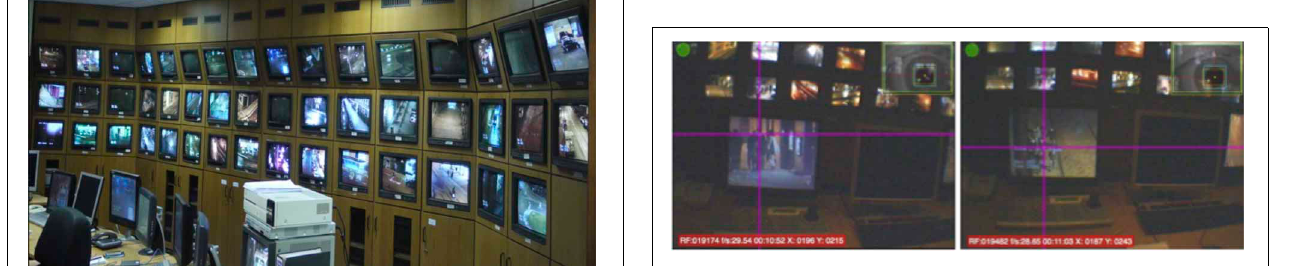
FIGURE 2 | Tayside Police control room.